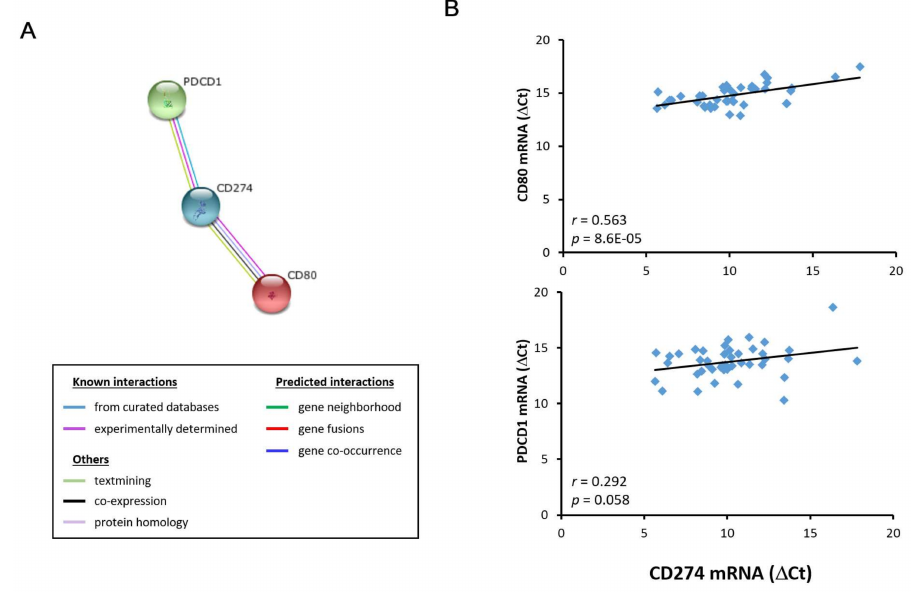
Figure 6. Correlation analysis of CD274 and its related molecules in liver grafts from transplant recipients. ( A ) Bioinformatics analysis revealed that CD80 and PDCD1 were CD274 -related molecules; ( B ) CD80 , but not PDCD1 , demonstrated a positive gene expression correlation with CD274 in liver grafts from 43 transplant recipients using